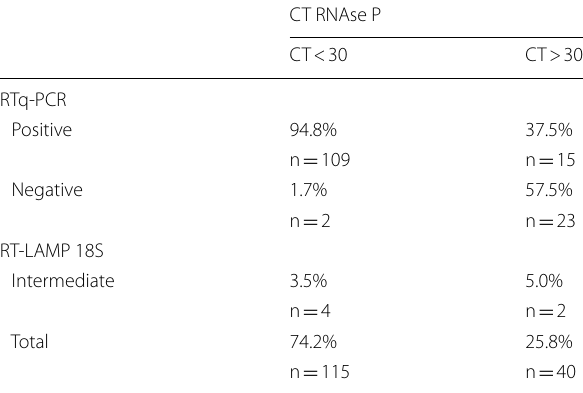
Table 3 RT-LAMP detection of 18S gene used as internal control CT RNAse